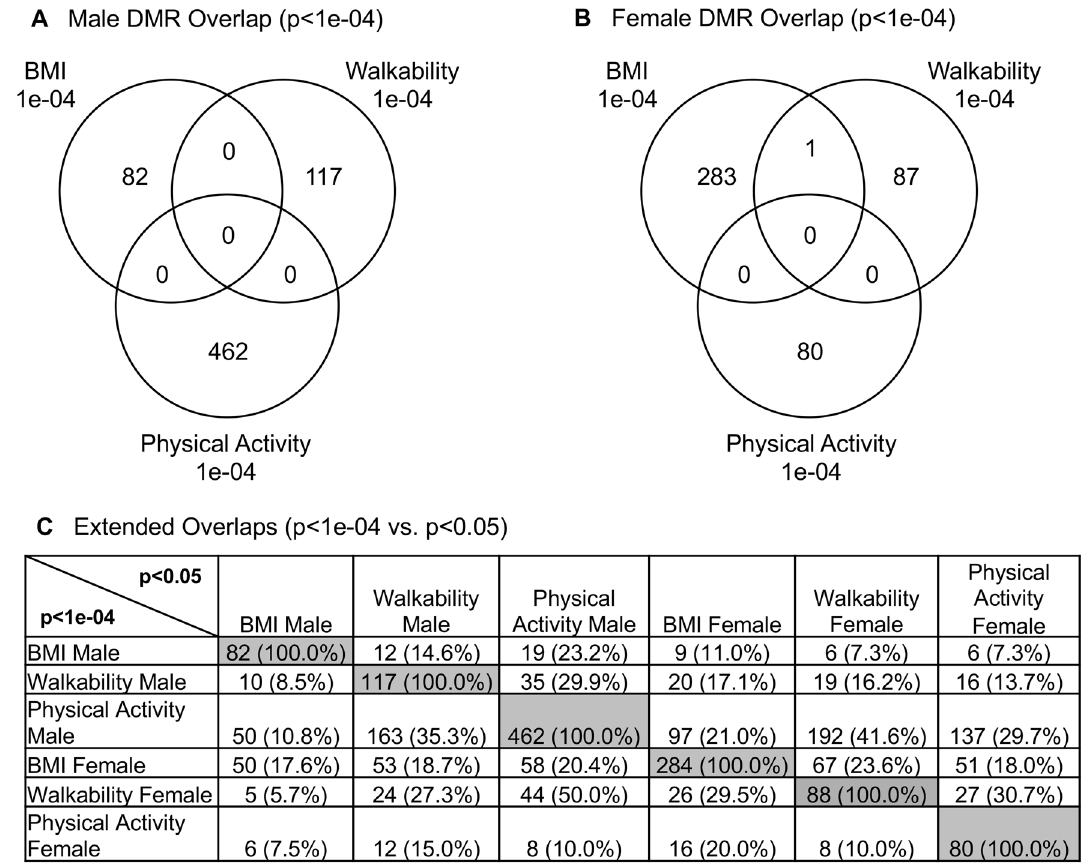
Figure 2. Discordant DMR overlaps. ( A ) Male DMR p < 1e−04 Venn diagram overlap. ( B ) Female DMR p < 1e−04 Venn diagram overlap. ( C ) Extended overlaps with p < 1e−04 and p < 0.05 comparisons. DMR number and percent (%) overlap presented within the